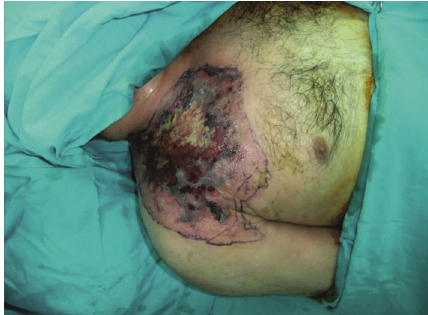
Figure 1: Photograph of the patient showing the signs of necrotiz- ing fasciitis, including necrosis, edema, erythema, and induration on the skin.